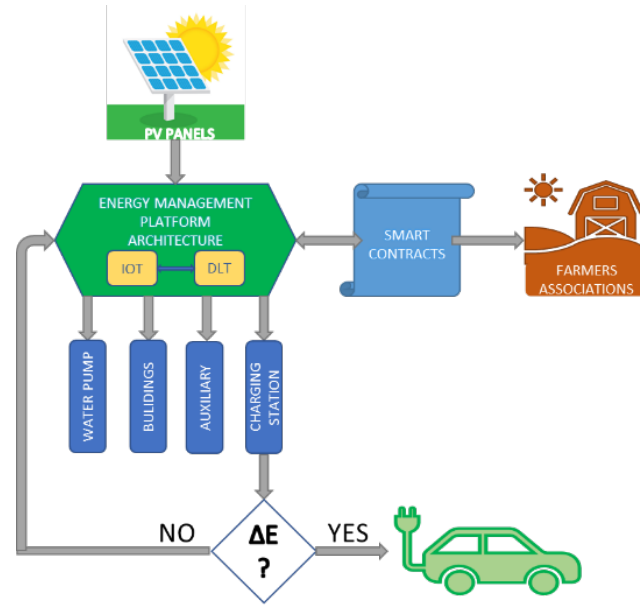
Figure 2. Flowchart of energy management platform architecture.